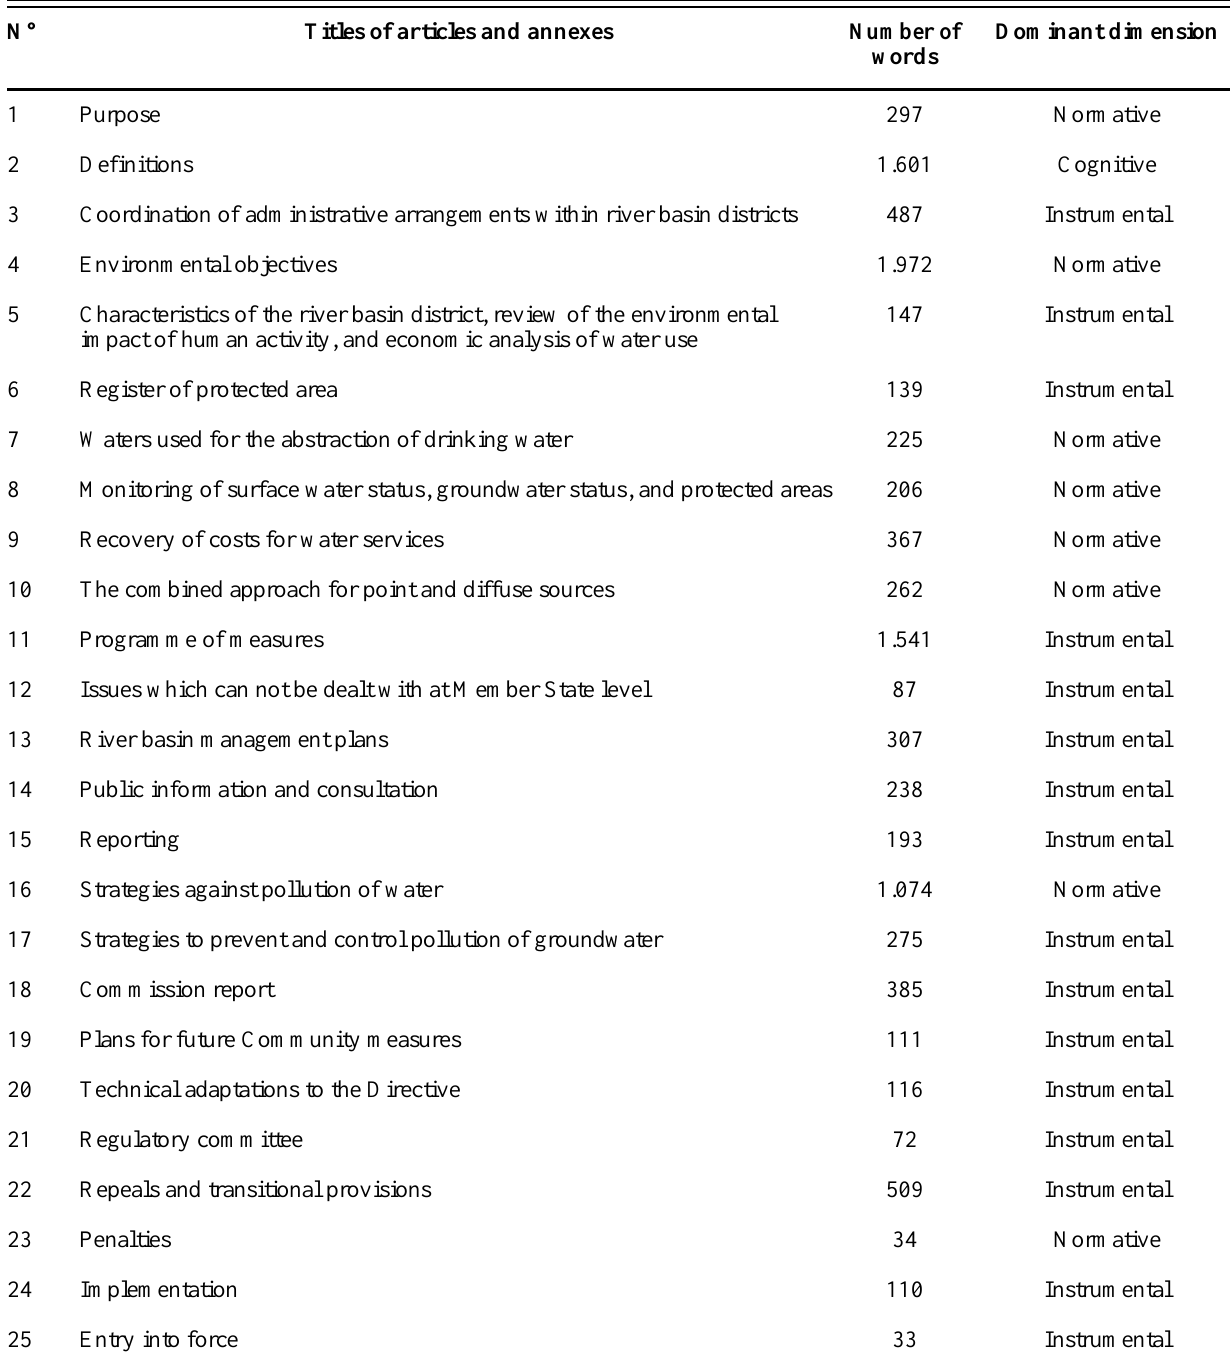
Table 1. An overview of the general balance of the Water Framework Directive (WFD) articles and annexes among cognitive, normative, and instrumental